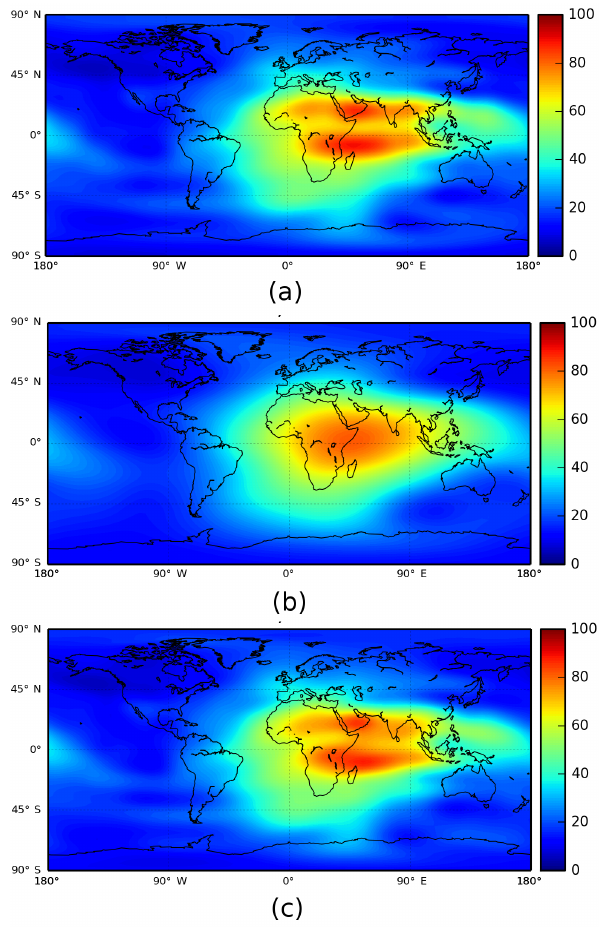
Figure 2. Reconstructed VTEC maps: (a) a reference VTEC map obtained from IGS; (b) reconstruction following Eq. (6) with B- spline levels J 1 = 3 and J 2 = 1; (c) same as (b) but with B-spline levels J 1 = 4 and J 2 =